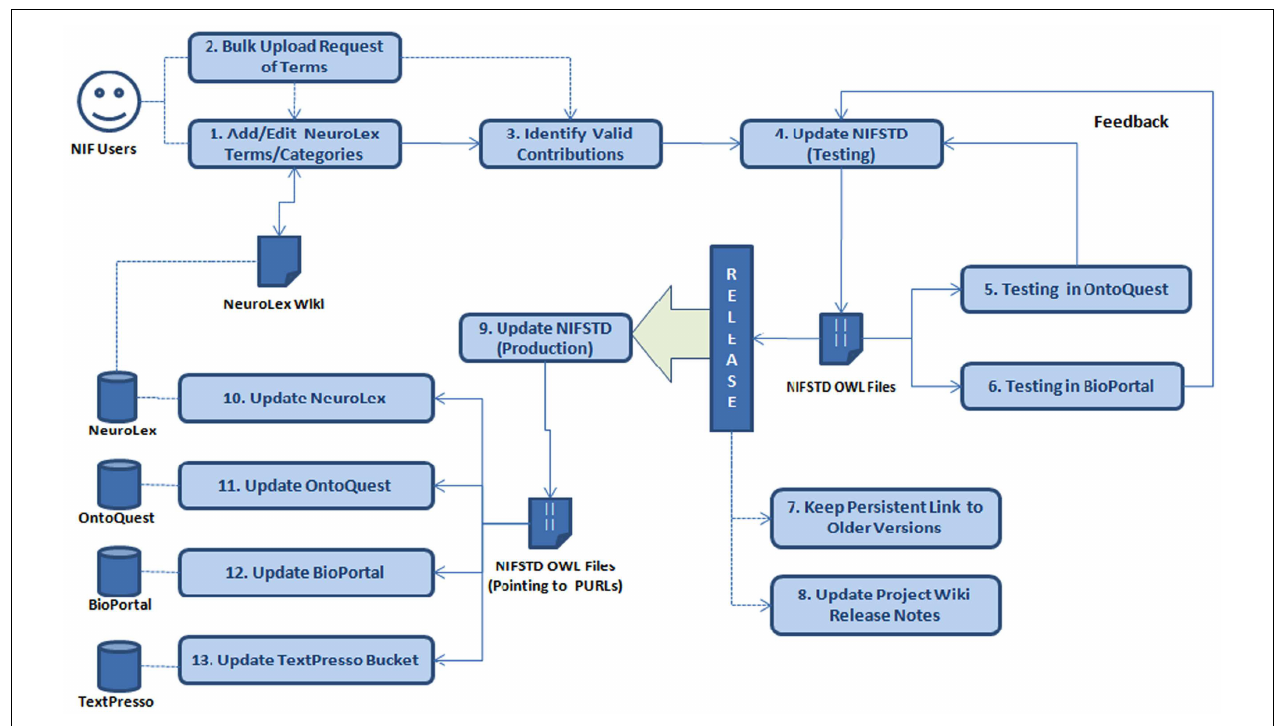
FIGURE 2 |Transition of contributions between the NeuroLex and the NIFSTD.